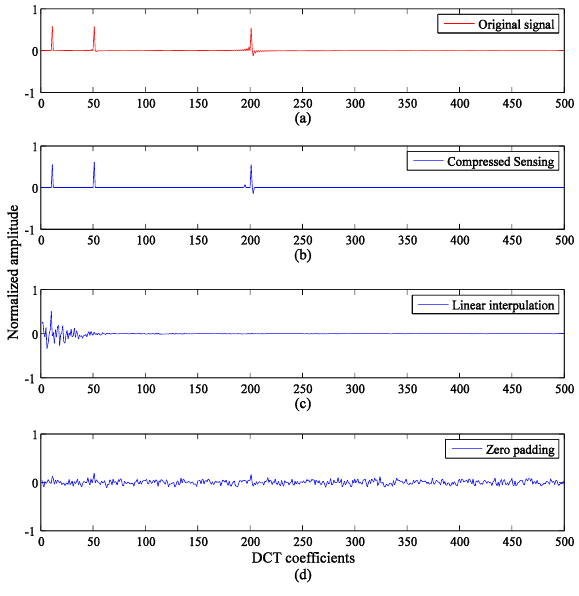
Figure 2. From top to bottom: Original signal, the result of compressed sensing reconstruction, the result of linear interpolation, and simple zero padding. All the signals are shown in the DCT domain and the amplitudes are